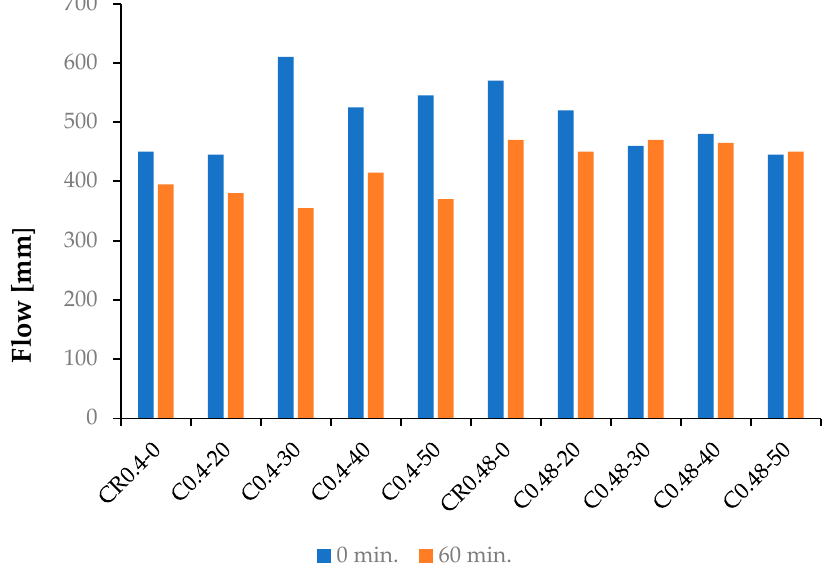
Figure 5. Results of the UWC mixes consistency testing after 0 and 60 min from mixing. Table 4. Results of UWC mixes’ consistency and wash-out loss